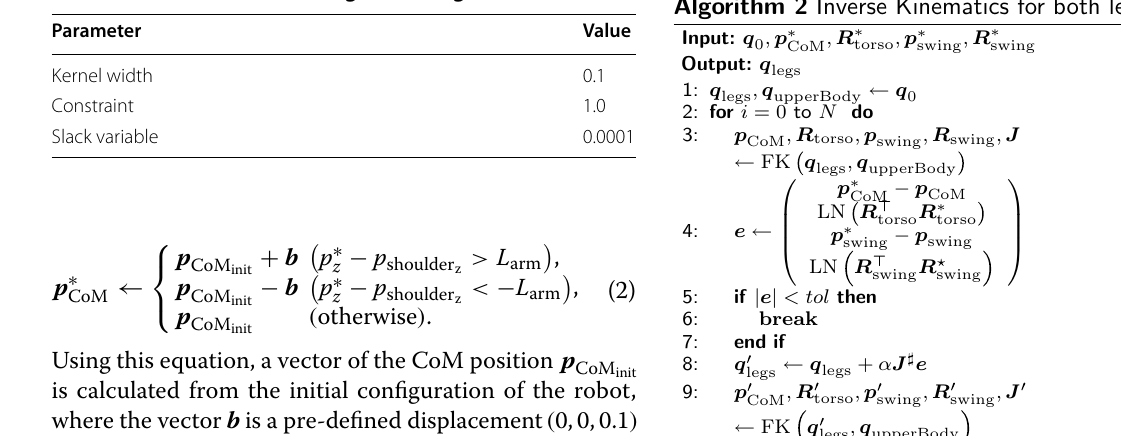
Table 1 Parameters for the regression algorithm